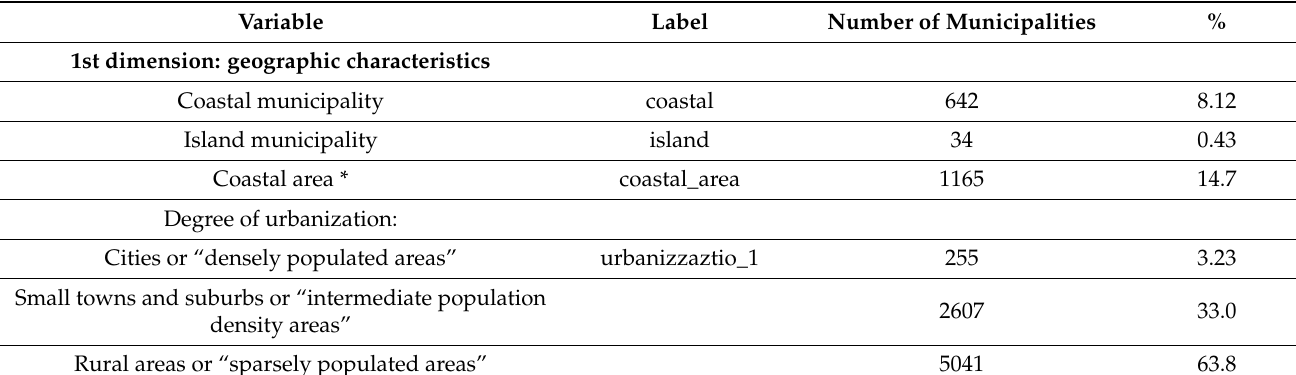
Table 2. Distribution of the 7903 Italian municipalities with respect to contextual categorical variables for each dimension under